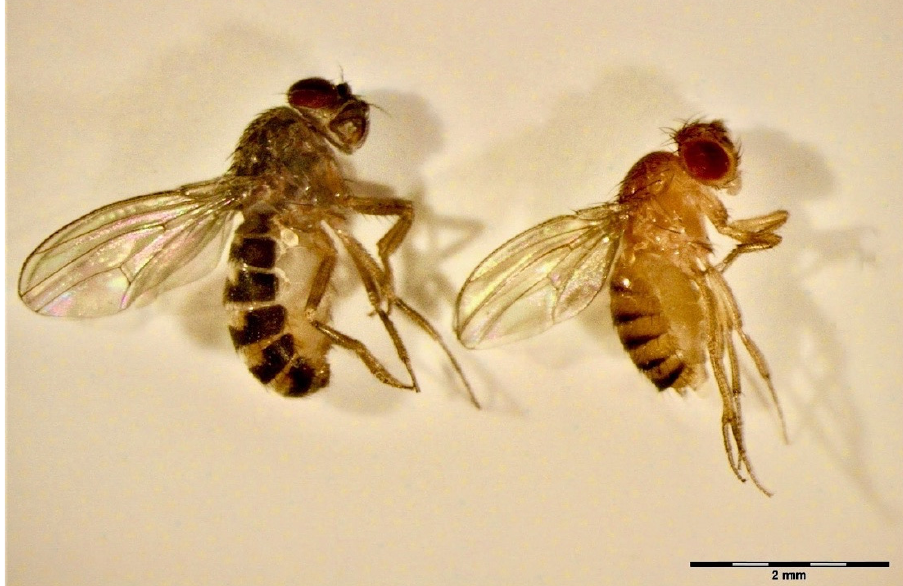
Figure 1. The flightless forms of D. hydei ( left ) and D. melanogaster ( right ) used in the experiments.